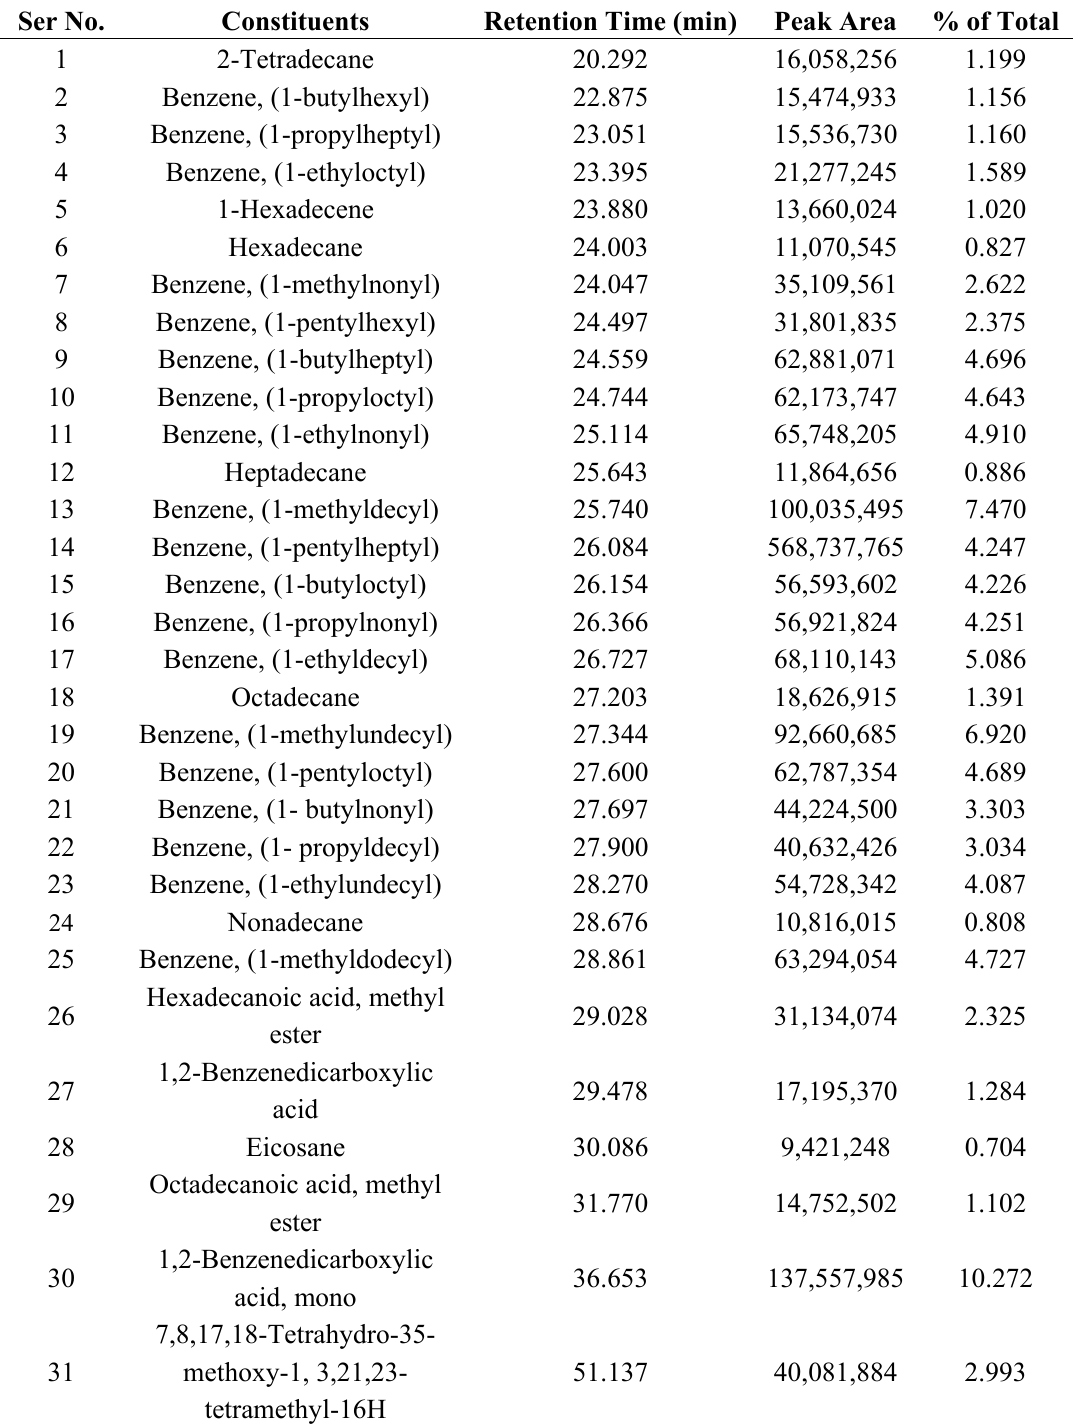
Table 1. GC MS-MS analysis showing the chemical constituents of oily sub-fraction A. Ser